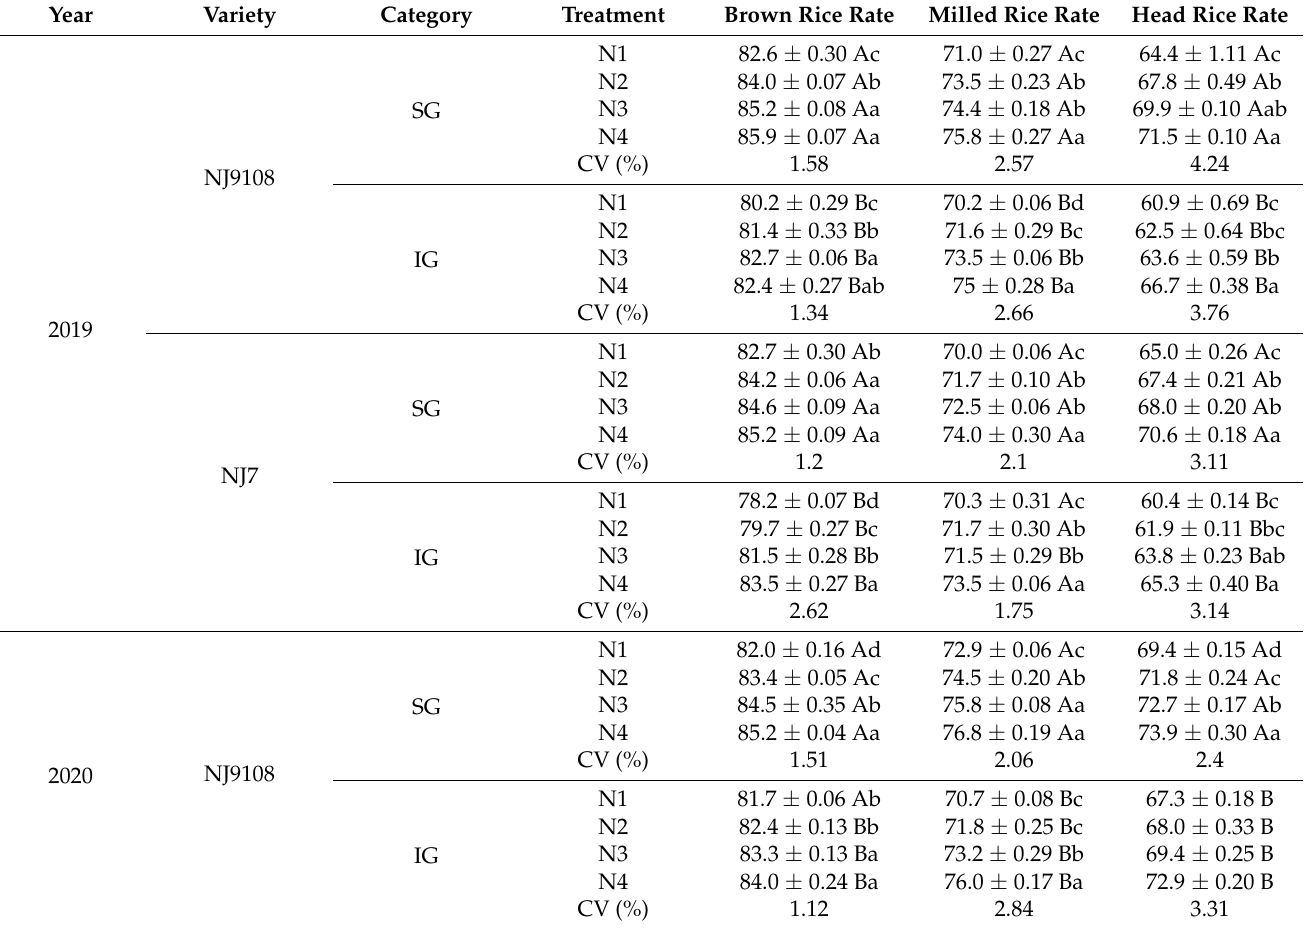
Table 2. Effects of nitrogen fertilizer levels on processing quality of superior and inferior grains